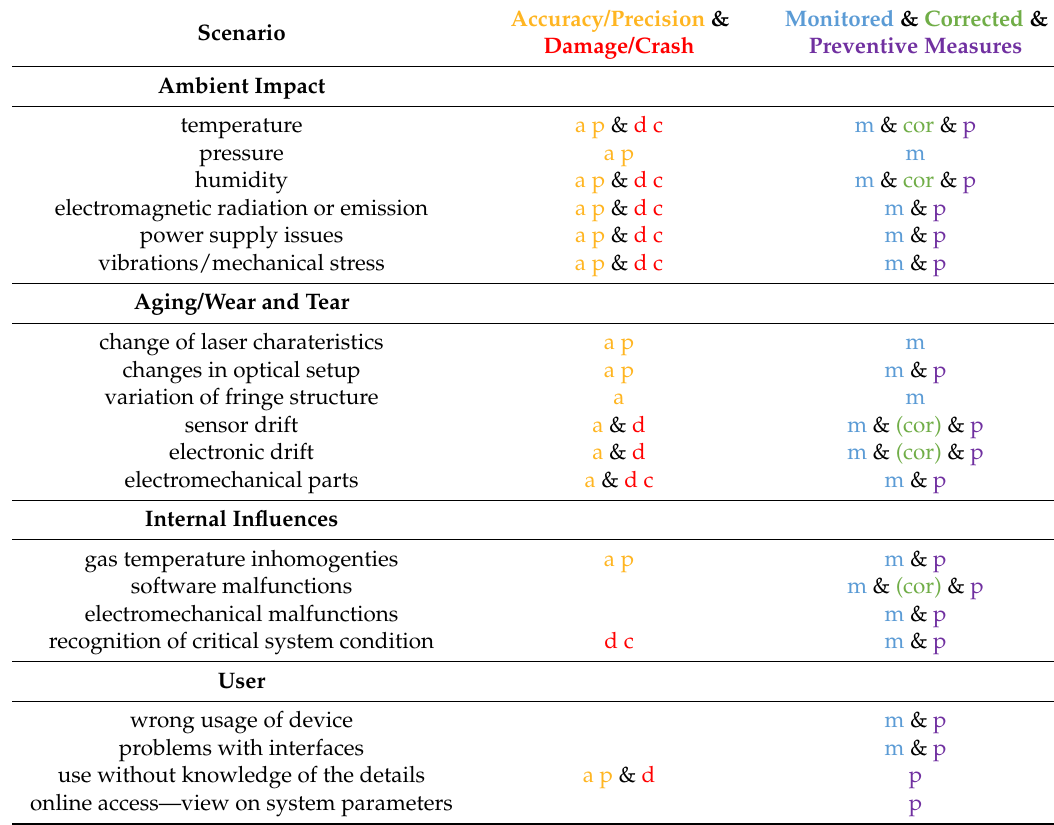
Figure 4. Classification of the values acquired by the control sequence software: Data from sensors and interfaces, output of the built-in algorithms, exception handling, and memory management. Table 1. This Table describes different scenarios which could happen during operation, e.g., an ambient humidity change (first division, third line) can affects accuracy “a” and precision “p”, lead to a system crash “c” or even cause permanent damages “d” to the instrument. SEALDH-II monitors “m” this value, corrects the final measurement values for this effect “cor” and has preventive measures deployed “p” to keep the corrections a small as possible. A “(cor)” in the table means that corrections can be done in many cases, but not in all, e.g., related to software crashes this means that several software exceptions are handled but, similar to every computer system, not every scenario can be handled.